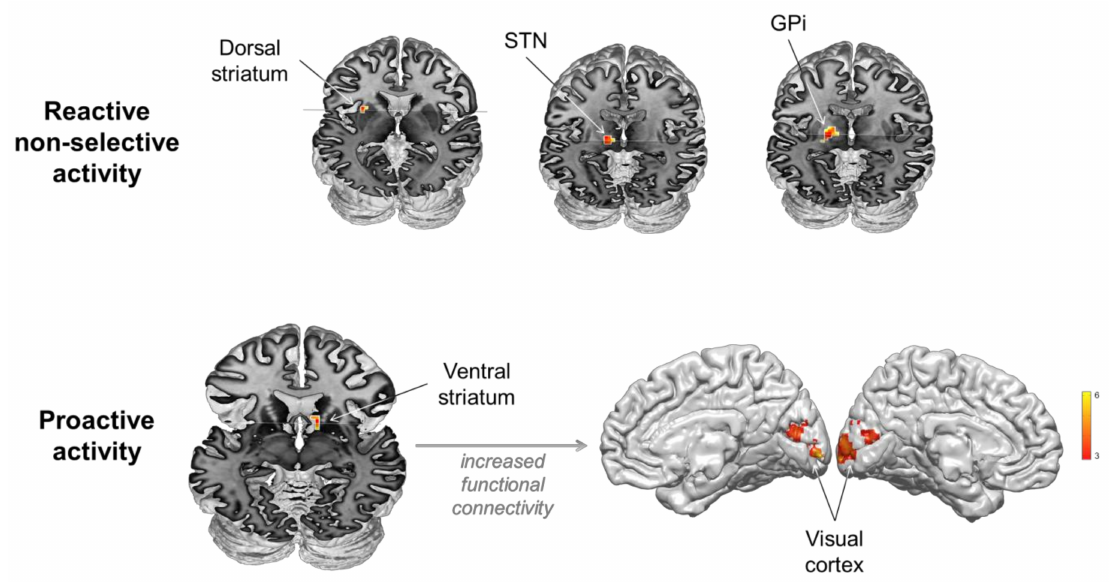
Figure 3. Involvement of the basal ganglia in reactive non-selective and proactive mechanisms during inhibitory